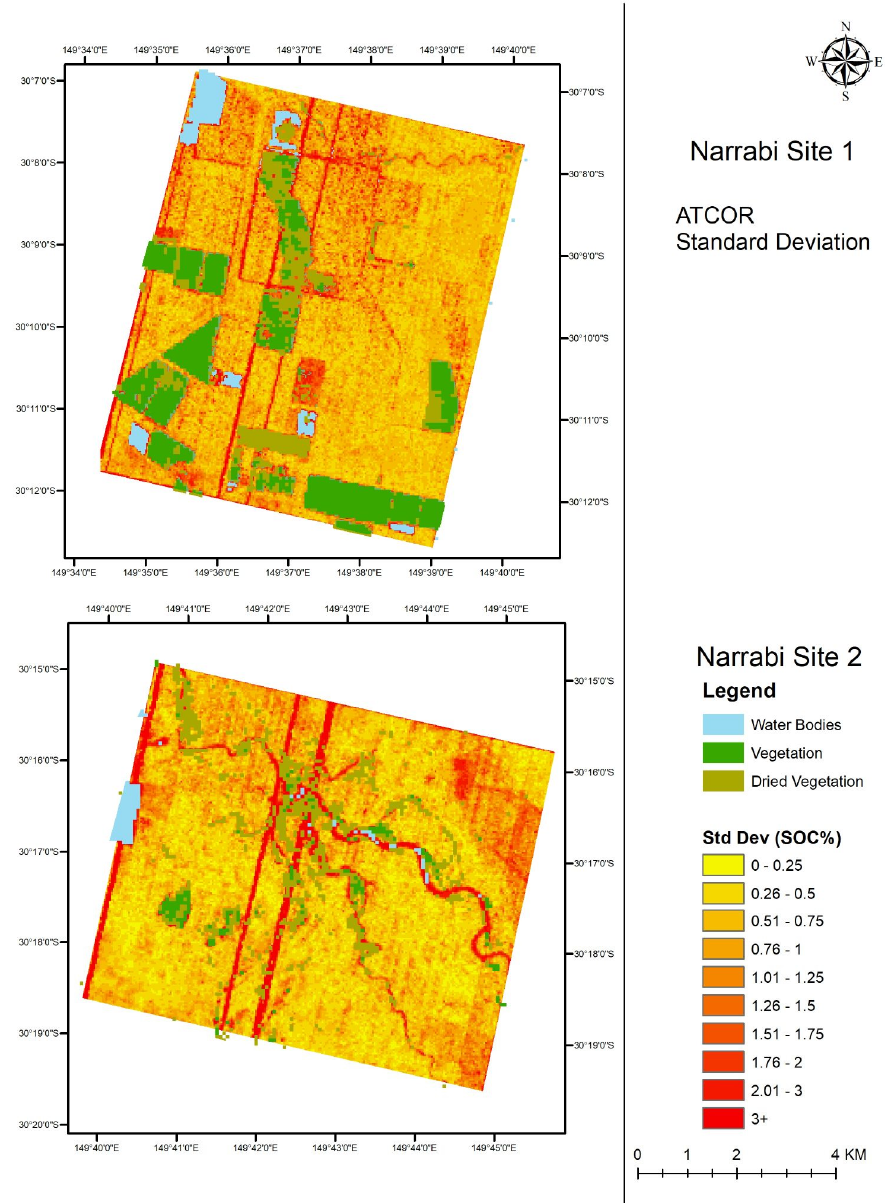
Figure 13. Standard deviation map of estimated SOC obtained along the six WV values used with ATCOR method.